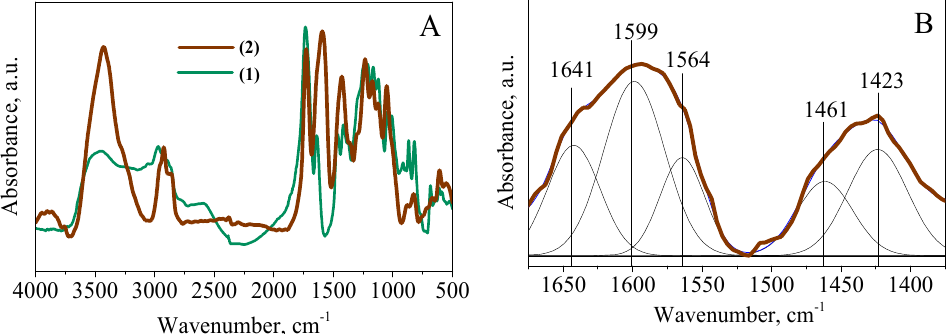
Figure 4. Infrared spectra of compounds 1 and 2 ( A ) and approximation of absorption bands of compound 2 in the region from 1675 to 1375 cm − 1 ( B ).